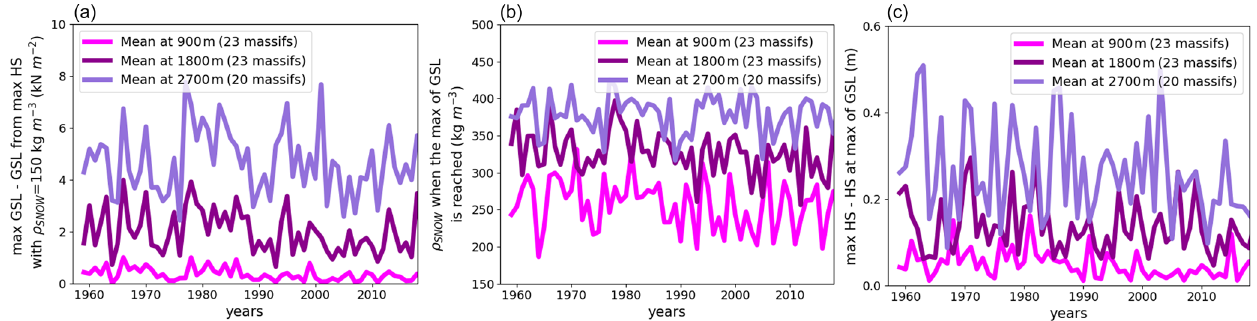
Figure 10. Limitation of approximating annual maxima of ground snow load (GSL) from annual maxima of snow depth (HS). (a) Difference between annual maxima of GSL and GSL computed from annual maxima of HS and ρ SNOW = 150kgm − 3 . (b) Snow density when annual maxima of GSL are reached. (c) Difference between annual maxima of HS and HS when annual maxima of GSL are reached.